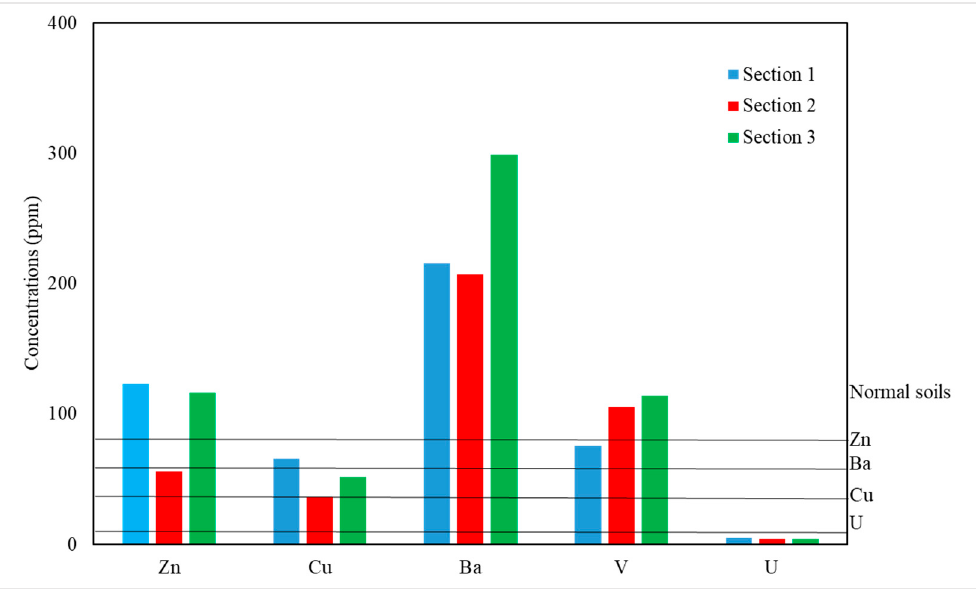
Figure 18. Concentrations of elements in soils generated from shales.